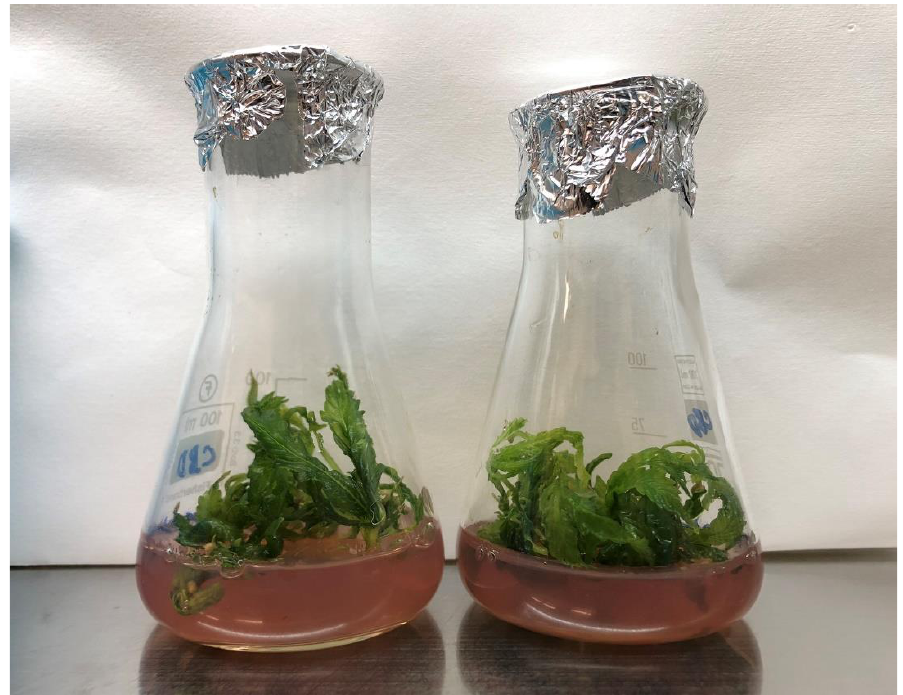
Figure 8. Multiplication of the ‘Tatanka Pure CBD’ cultivar on ViVi 6 culture medium to achieve the required amount of biomass to establish the experiment with PEO-IAA.